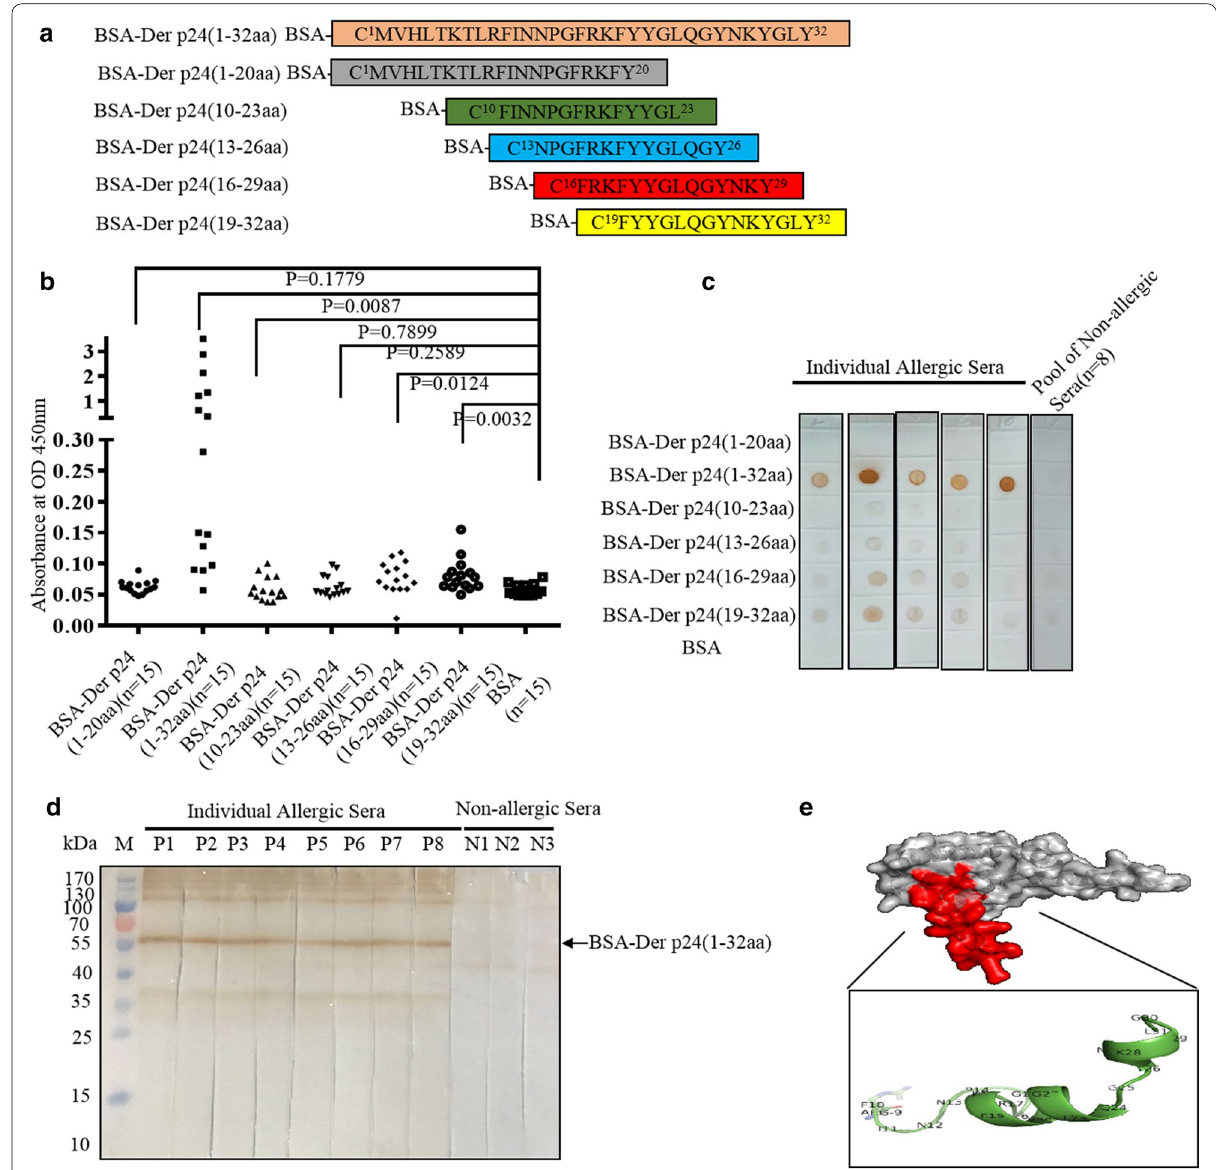
Fig. 3 Identification of N‑terminal 32 residues of Der p 24 is an immunodominant IgE epitope. a Synthesized overlapping polypeptides designed according to the N‑terminal 32 residue sequences and conjugated with BSA protein for comparative analysis of IgE binding reactivity. b IgE‑ELISAs of overlapping polypeptides with individual sera from 15 HDM‑allergic patients. P values < 0.05 were considered significant. c IgE‑dot blot of overlapping polypeptides (2 μg each) incubated with sera from 5 HDM‑allergic patients (P1–P5; subset from experiment in B with positive reactions) and pooled sera from 3 non‑allergic controls (N). d IgE‑western blot of BSA‑Der p 24(1–32aa) polypeptide conjugate with serum samples from 8 HDM‑sensitized patients (P1–P8) and 3 non‑allergic individuals (N1–N3). e Homology‑based three‑dimensional model of the structure of Der p 24, which included two alpha helices and two random coils. The N‑terminal‑32 residue region is labelled